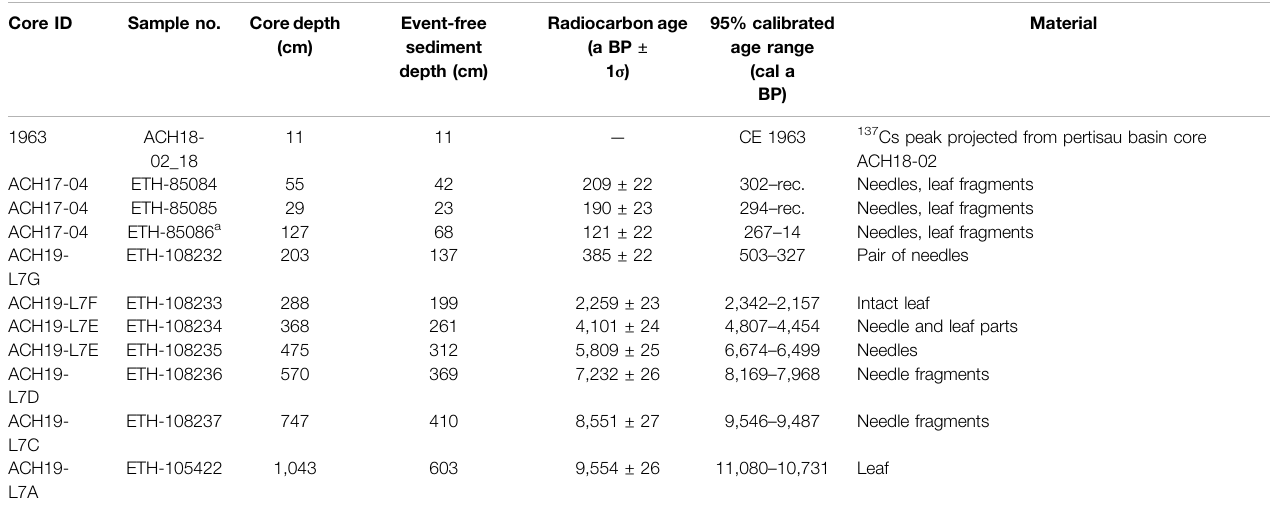
TABLE 1 | Radiocarbon ages of core